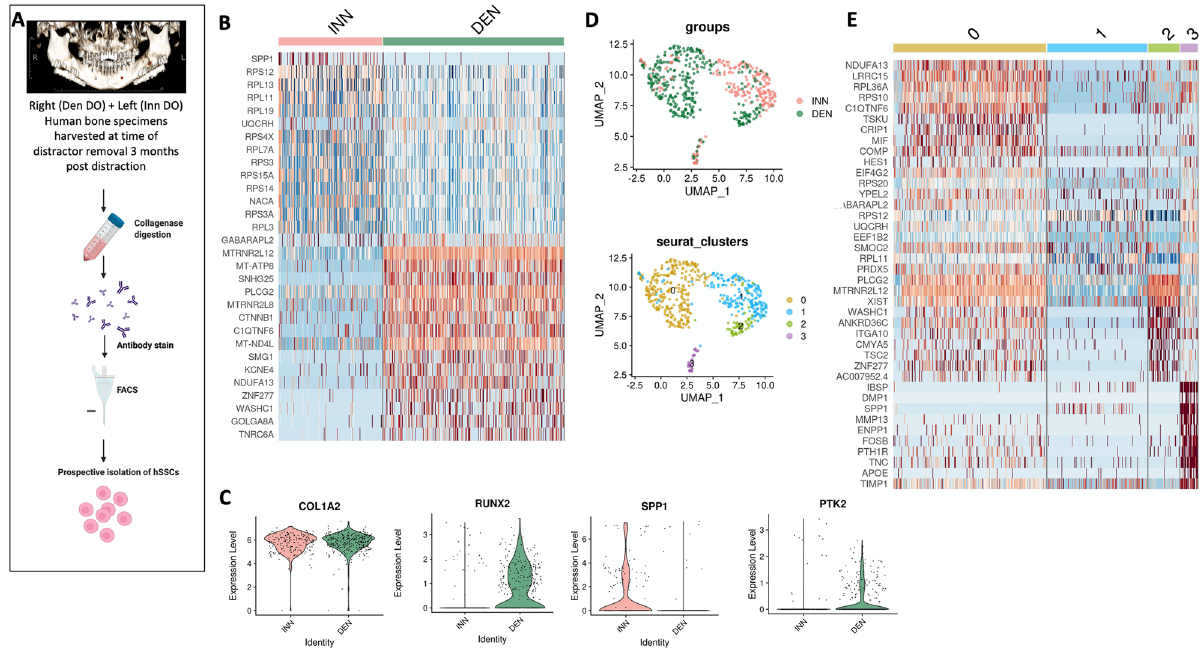
Figure 5. Human Mandible Distraction Regenerate scRNA Sequencing analysis. ( A ) Experimental schematic: hSSCs were prospectively isolated using FACS from mandible distraction regenerate at 3 months post distraction from bilateral hemi-mandibles: left with clinically intact IAN (Inn DO) and right with clinically absent IAN (Den DO) and underwent scRNA seq using the 10X genomic platform. Created with BioRender. com. ( B ) Heat map representing top differentially expressed genes characteristic of Inn DO and Den DO hSSCs. Red: upregulation; blue: downregulation. ( C ) Violin plots demonstrating transcriptional expression of left to right: COL1A2, RUNX2, SPP1, PTK2 in Inn DO hSSC (red) and Den DO hSSC (green). ( D ) Uniform manifold approximation and projection (UMAP) plot showing scRNA-seq data from (top) Inn DO (red) and Den DO (green) FACS-isolated hSSCs three months post distraction (Bottom) Four unique clusters of hSSCs are identified. Colors as labeled in the figure panel. ( E ) Heat map representing top differentially expressed genes characteristic of the four unique clusters of hSSCs. Red: upregulation; blue: